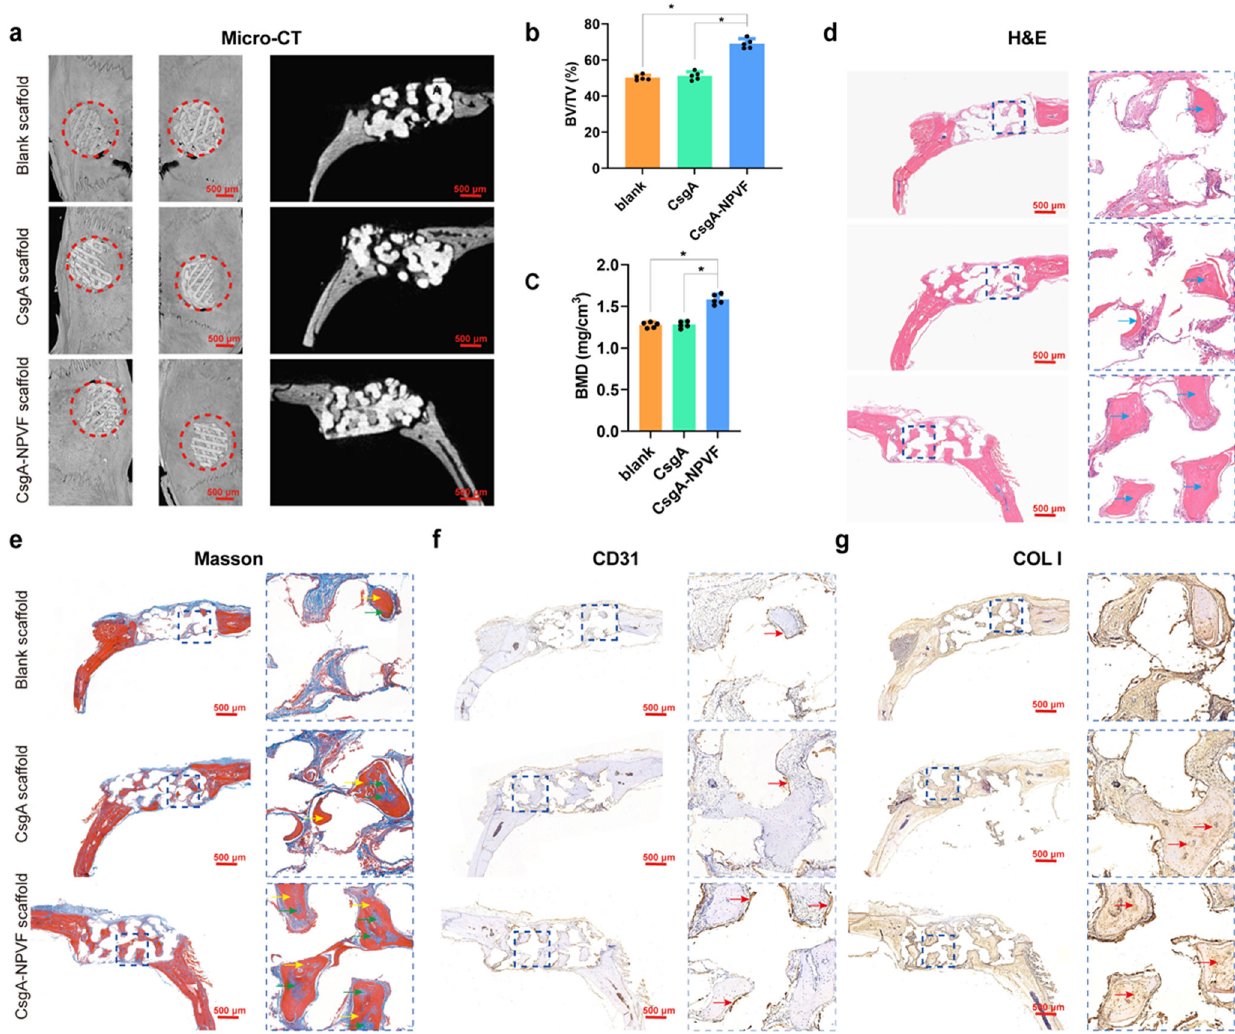
Fig. 6 CsgA-NPVF nano fi ber-coated scaffolds promote bone defect repair in a rat calvarial defect model. a 3D reconstructed (left) and 2D sagittal (right) micro-CT images of the bone defects. b, c The quanti fi cation of BMD and BV/TV in the new bone. Results are presented as means ± S.E.M. of fi ve animals, and the P values from left to right are 0.0009, 0.0001, 0.0008, and 0.0003. * P < 0.05, one-way ANOVA. d Histological analysis of new bone in- growth using H&E (blue arrows indicate new bone formation). e Masson ’ s histological analysis of new bone formation (green arrows show less mature fresh bone and yellow arrows point to mature bone tissue). f Histological observation of CD31 staining (red arrow shows positive staining for